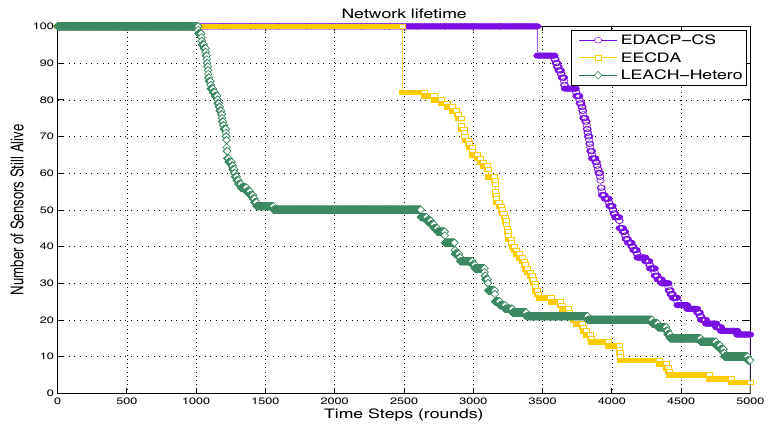
Figure 8. Number of alive nodes over